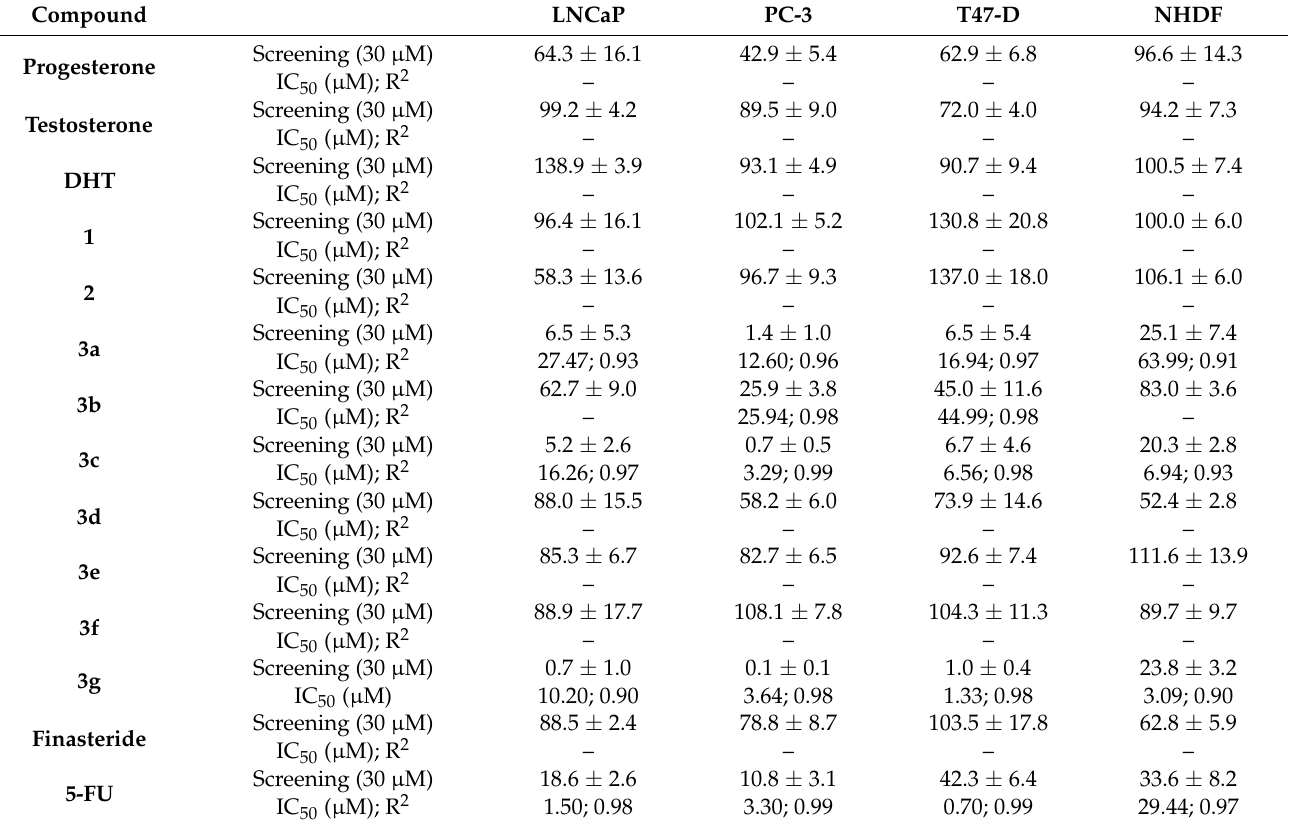
Table 2. In vitro antiproliferative activities of the tested compounds against LNCaP, PC-3, T47-D and NHDF cell lines, after 72 h of exposure. MTT screening results at 30 µ M (data presented as average percentage of negative control ± SD) and determined IC 50 values ( µ M) with the respective R squared (R 2 ) 1